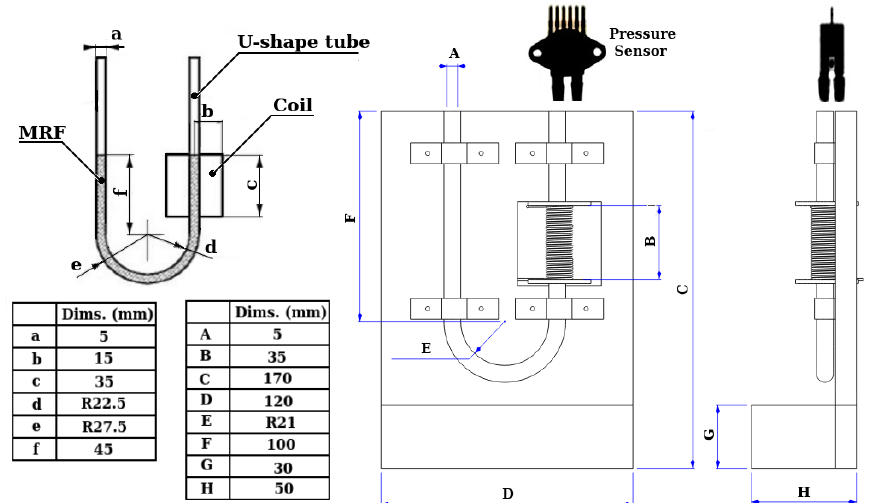
Figure 4. The U-shaped tube and other testing